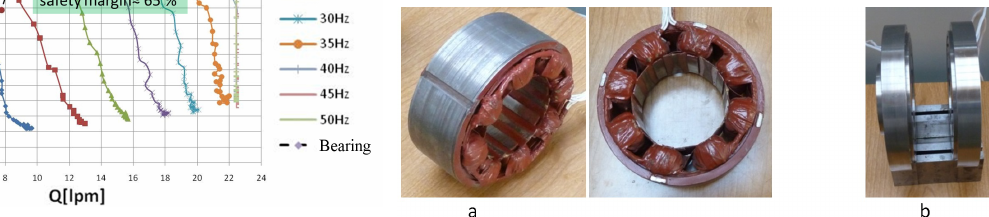
Figure 11: Volumetric flow of the incoming MDM through a single hybrid bearing system and a selected low rate hermetic pump